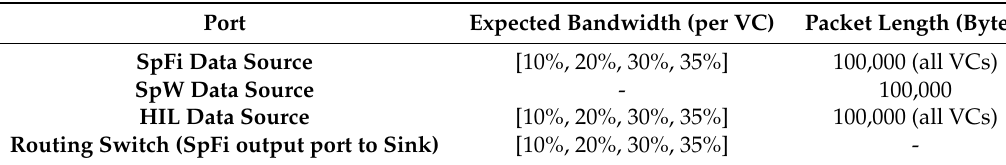
Table 2. Ports configuration parameters.